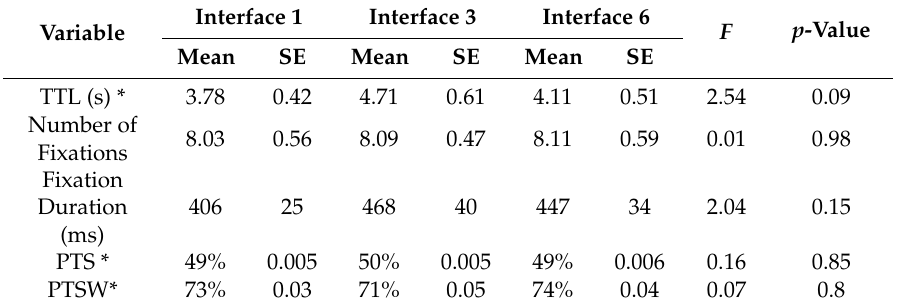
Table 2. Mean and standard error of the mean for the variables analyzed in the driving